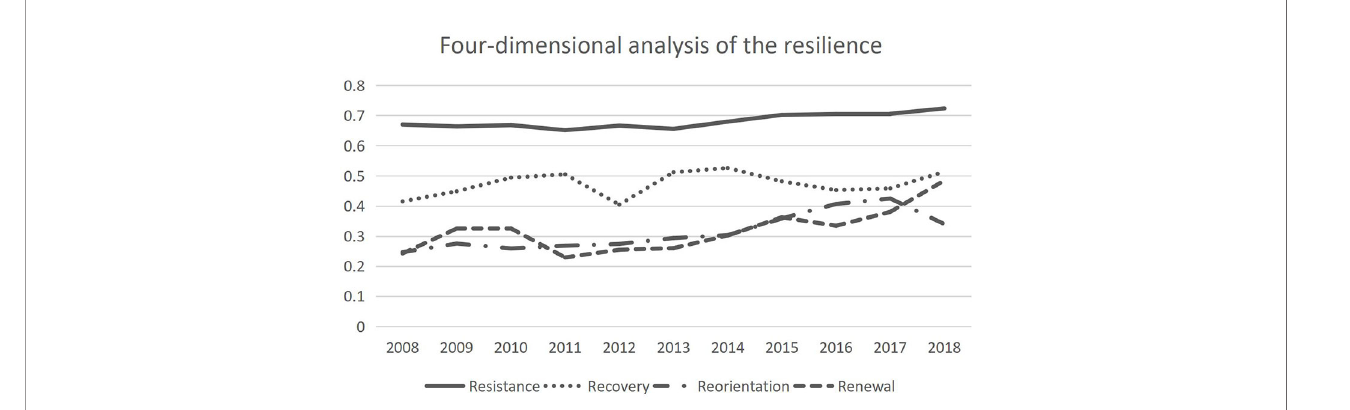
FIGURE 1 | Four-dimensional analysis of the resilience of the marine economy in China ’ s Southern Marine Economy